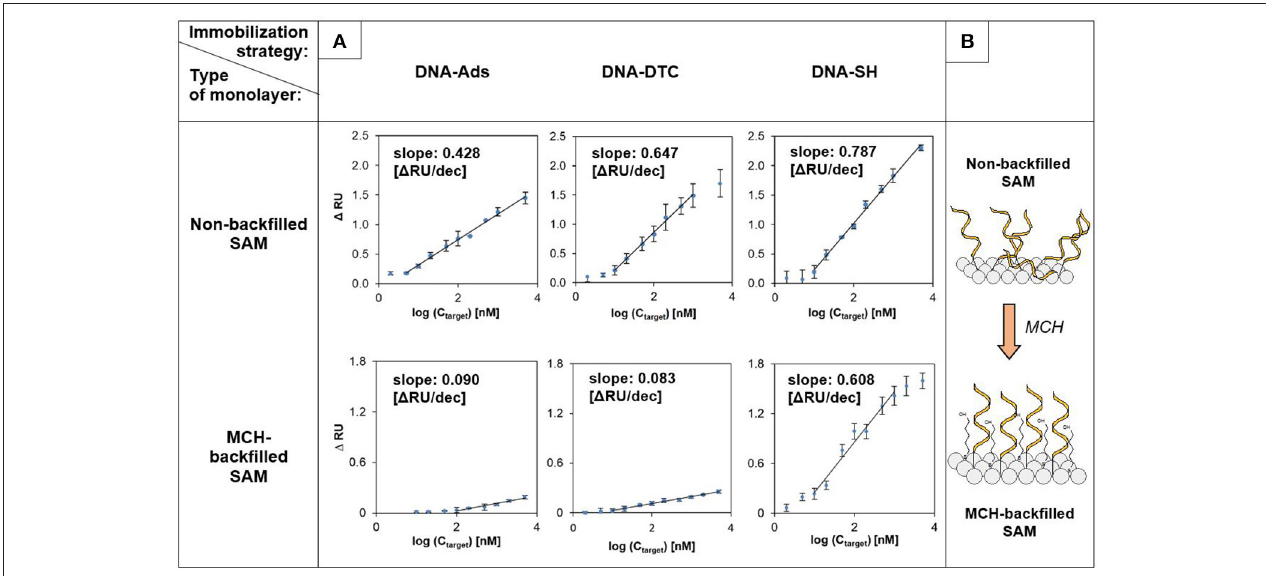
FIGURE 3 | SPRi calibration curves and analytical parameters obtained for various immobilization strategies ( n = 3) . (A) Comparative results for non-backfilled (top row) and MCH-backfilled (bottom row) DNA-SAMs. (B) Schematic illustration of DNA-monolayer reorganization induced by MCH. Random sequence ( Rand ) was injected into the reference cell throughout experiments. “ n ” value corresponds to the number of detection areas for which reflectance changes (independent sensograms) were recorded.